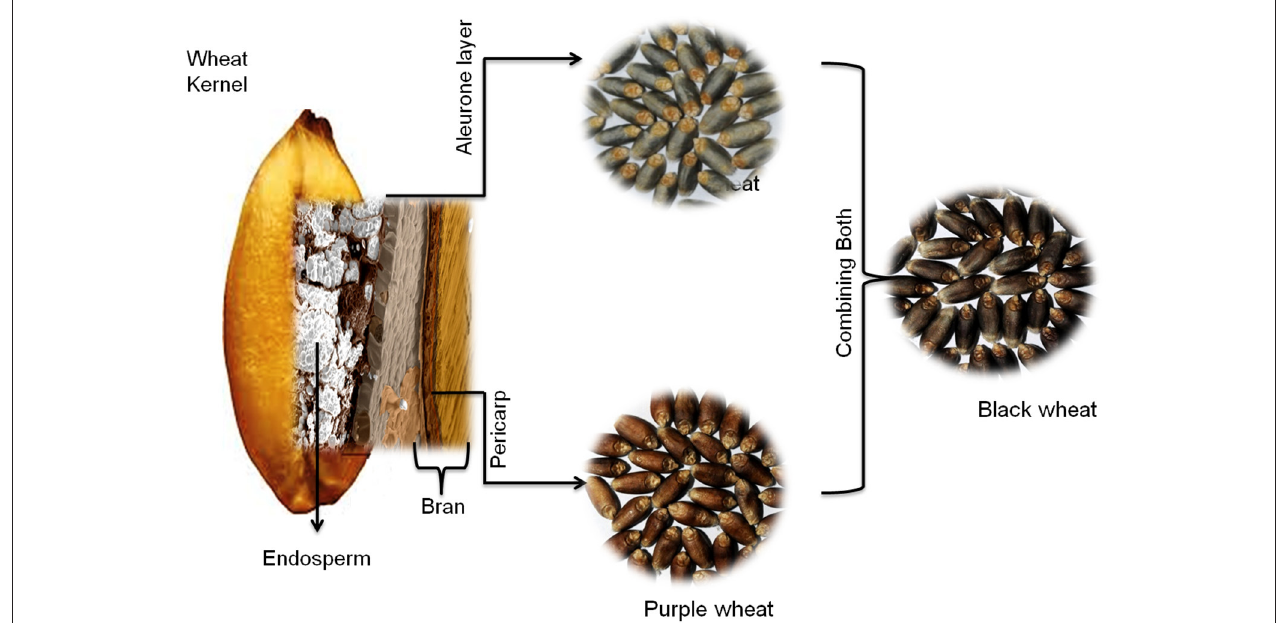
FIGURE 1 | Localization of anthocyanins in different layers of wheat seed. Purple wheat contains anthocyanins in the pericarp layer, blue wheat has anthocyanins in the aleurone layer, and black wheat is a mixture of both, with anthocyanins in both the pericarp and aleurone layers.